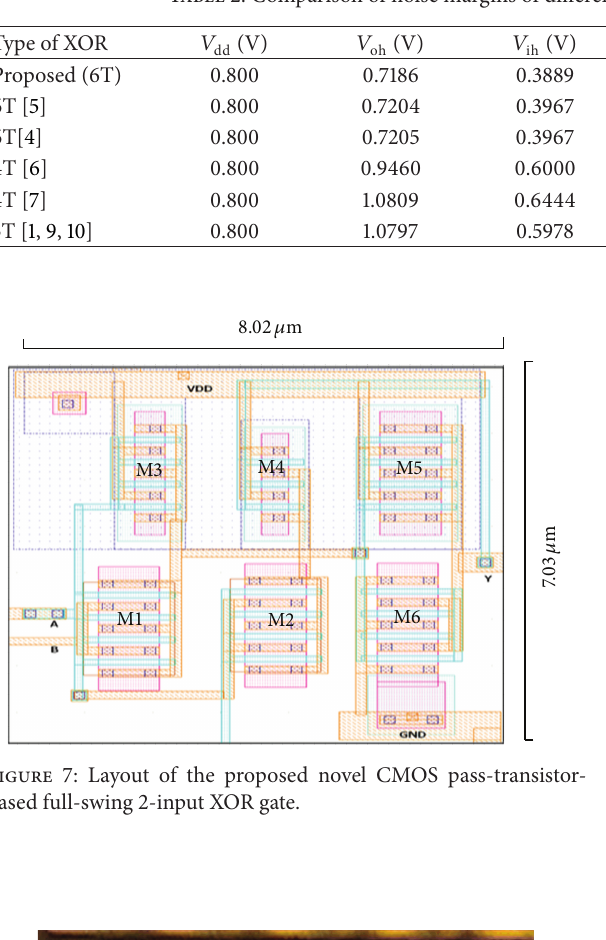
Figure 10: Oscilloscope waveforms for the fabricated novel CMOS pass-transistor-based full-swing XOR gate (yellow = input A, blue = input B, and green = output